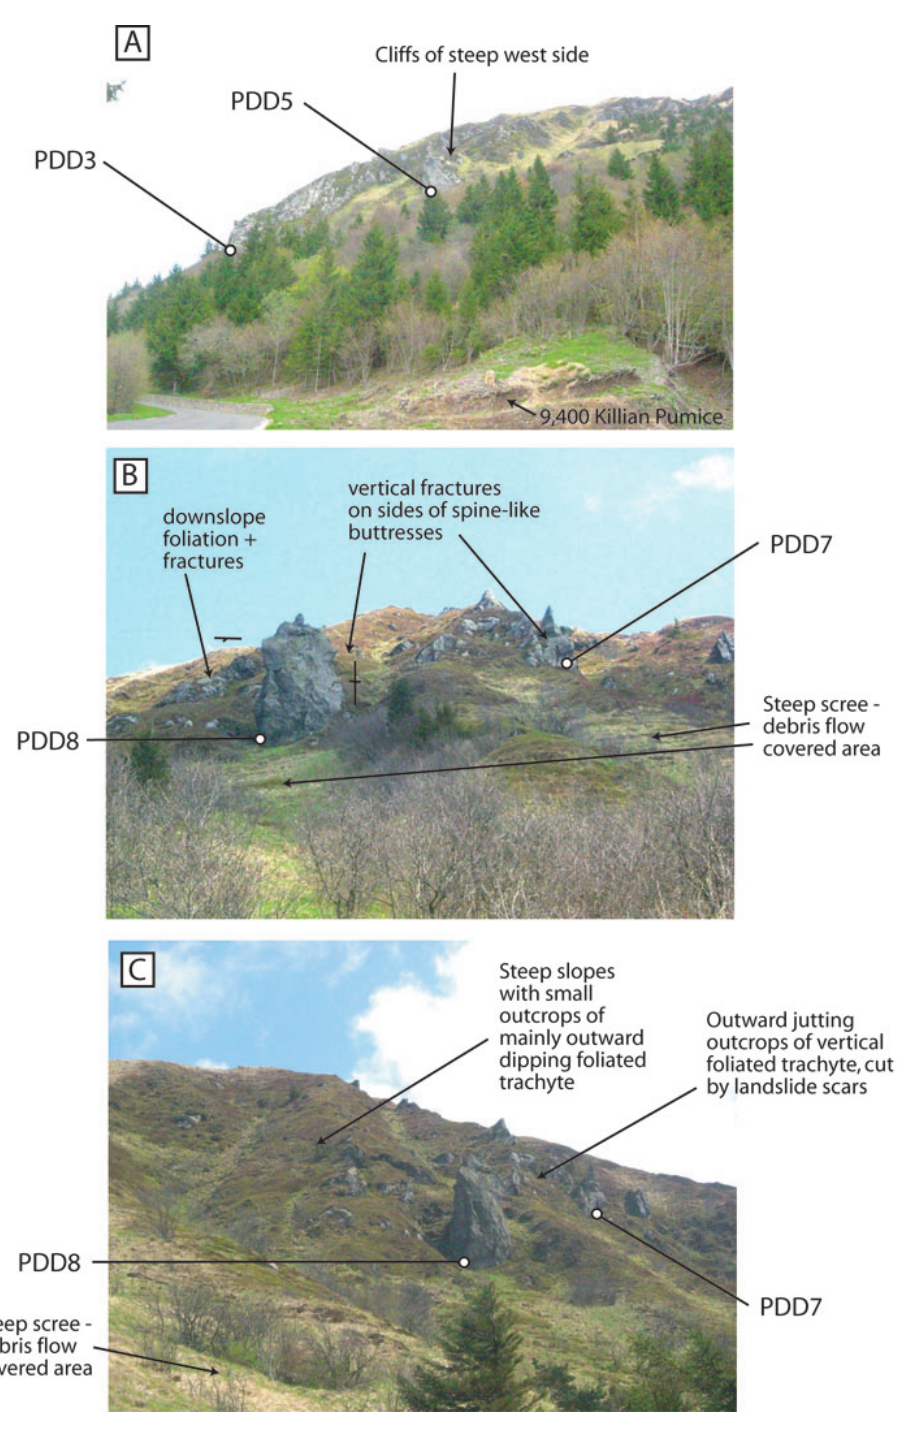
Figure 8: Pictures taken from the Puy de Dôme, of its slopes. [A] Looking over the old road (now train track) from the southwest side up to the west side and sample points PDD3 and PDD5. The former forms a large cli ff buttress (Figure 8B) with fractures above and below the sampling site that retains a highly fractured down- slope dipping plane. The outcrops above could be an arrested or potential landslide (see Figure 9 for close up images). [B] Sample sites PDD7 and PDD 8 on the west side of the steepest part. These have steeply outwardly dipping foliation, producing slabby outcrops. Vertical radial fractures are also seen, which guide the sides of deep landslide-controlled gullies. [C] Same sample sites as [B], but viewed from the northwest